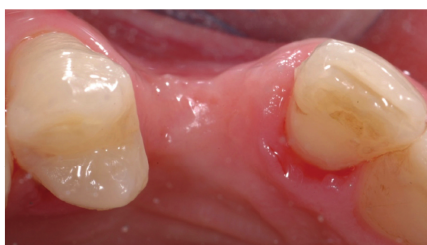
Figure 2: Clinical view of the occlusal aspect of the edentulous ridge.